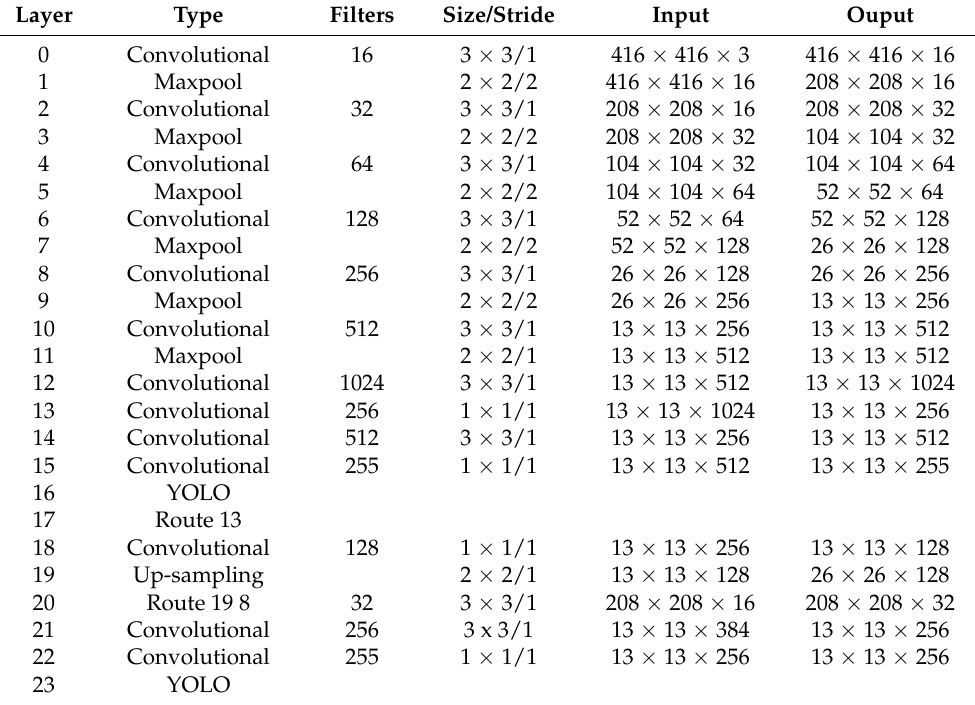
Table 1. Tiny YOLOv3 architecture.